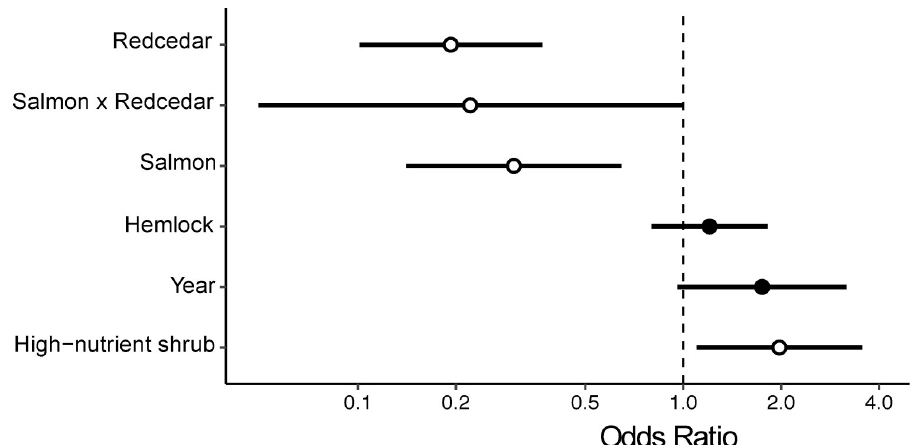
Fig 5. Odds ratio of habitat selection by territorial male wrens compared to habitat vegetation characteristics and stream-level spawning salmon biomass from the top AIC model. The standardized (mean = 0, SD = 2) parameters include redcedar stand basal area (m 2 ha -1 ), salmon biomass (kg), their interaction, hemlock stand basal area (m 2 ha -1 ), year, and percent high-nutrient shrub cover (stink currant and salmonberry). Circles show odds ratios for each parameter, with 95% confidence intervals indicated by horizontal lines. The odds ratios significantly different from 1 (95% CI do not overlap 1) are indicated by open circles.